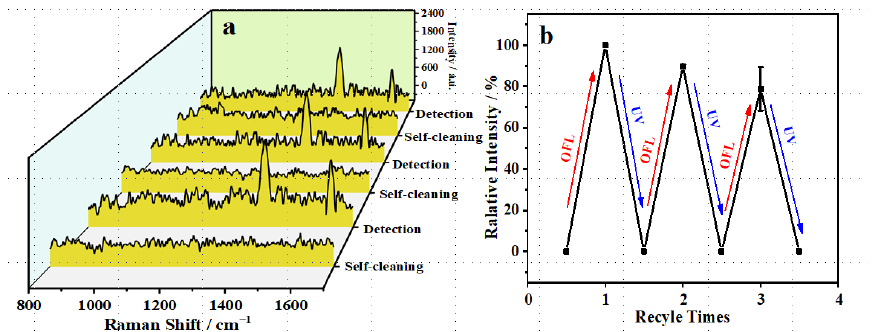
Figure 8. The Raman spectra of OFL at 10 − 5 M with the TM@TiO 2 @Ag before and after irradiation with UV light ( a ); SERS responses of OFL upon three repeated detections and UV irradiations ( b ).